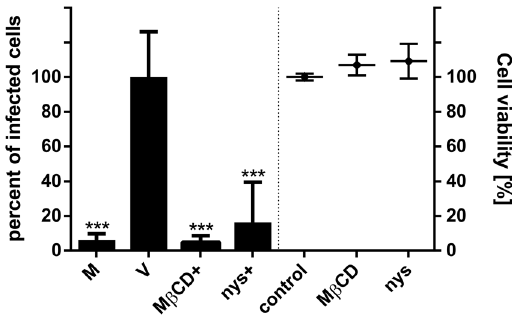
Figure 6. Inhibition of HCoV-OC43 infection in HCT-8 cells by M β CD and nystatin. HCT-8 cells pre-treated with cholesterol-sequestering agents were infected with HCoV-OC43 and analysed by flow cytometry 3 days p.i. The infection efficiency determined with flow cytometry is expressed as the percentage of HCoV-OC43 infected cells, compared to the untreated control, and is presented on the left side of the graph. Right part of the graph shows the cell viability, as determined with an XTT assay. M β CD − 5 mM M β CD treated cells; nys − 10 μ g/ ml nystatin treated cells; control − PBS treated cells; M – mock infected cells; V or + − HCoV-OC43 infected cells. The data is presented as the mean of a triplicate for each sample ± SD. To determine the significance of differences between compared groups, Single-Factor Analysis of Variance (ANOVA) was applied. *** P values < 0.05 were considered